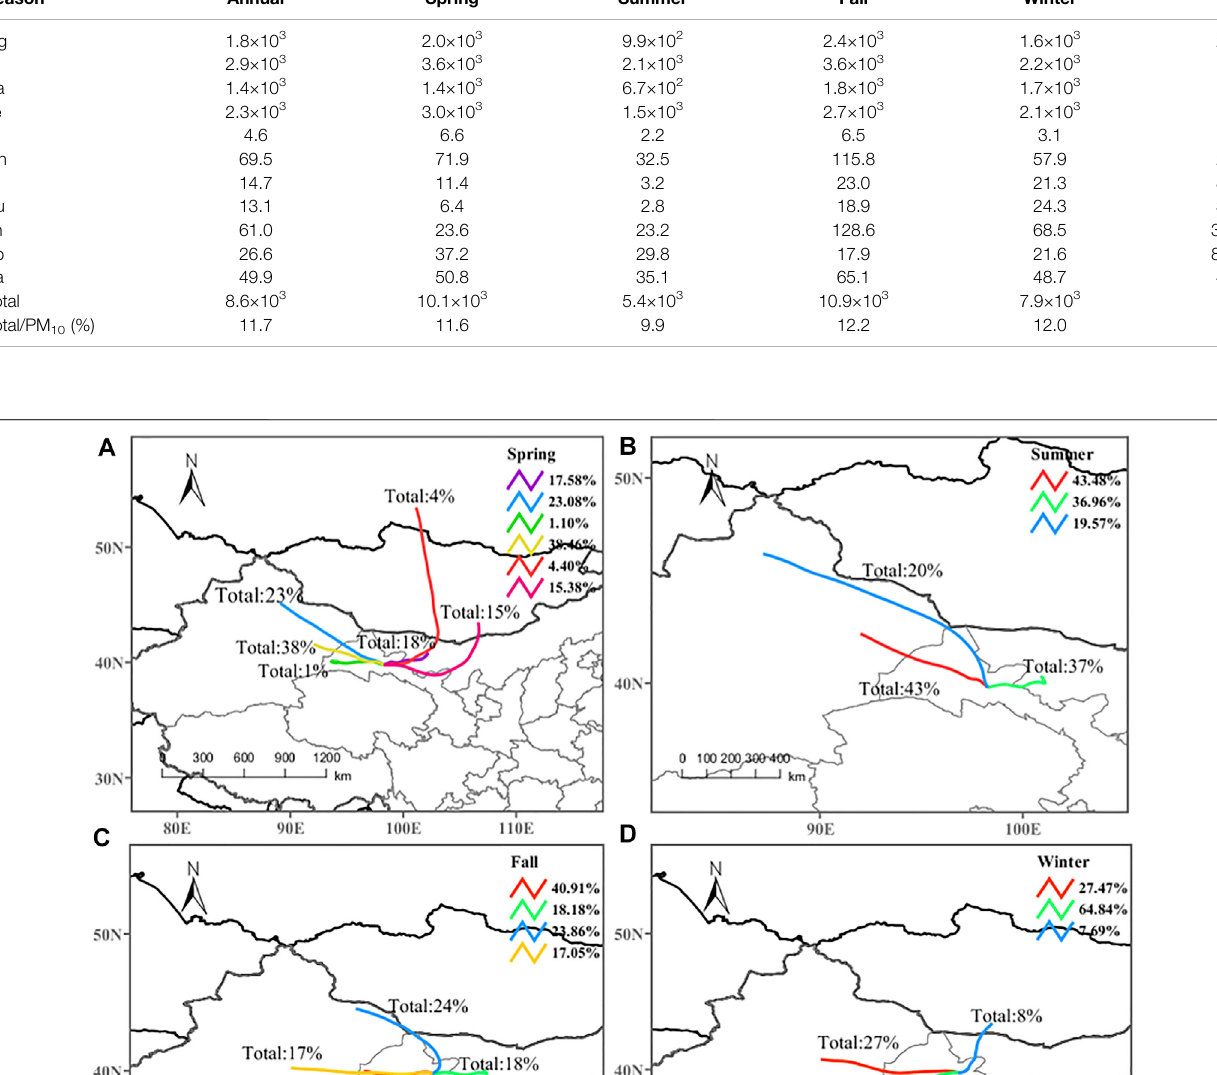
Frontiers in Environmental Science |